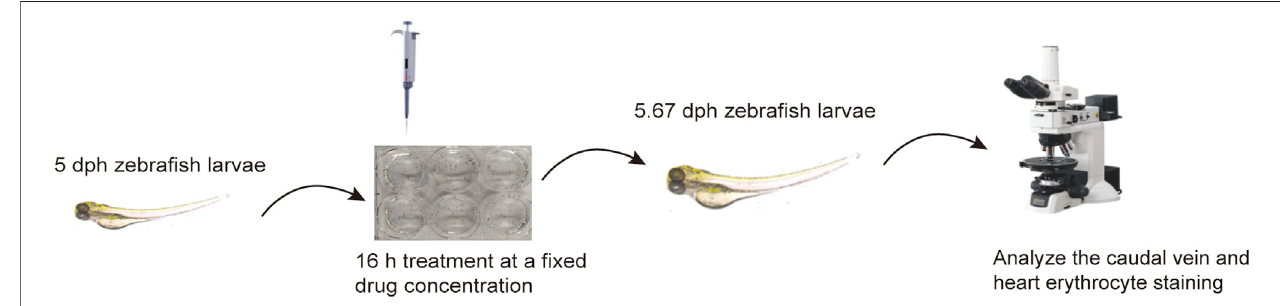
FIGURE 2 | The procedure of LEO antithrombotic experimental